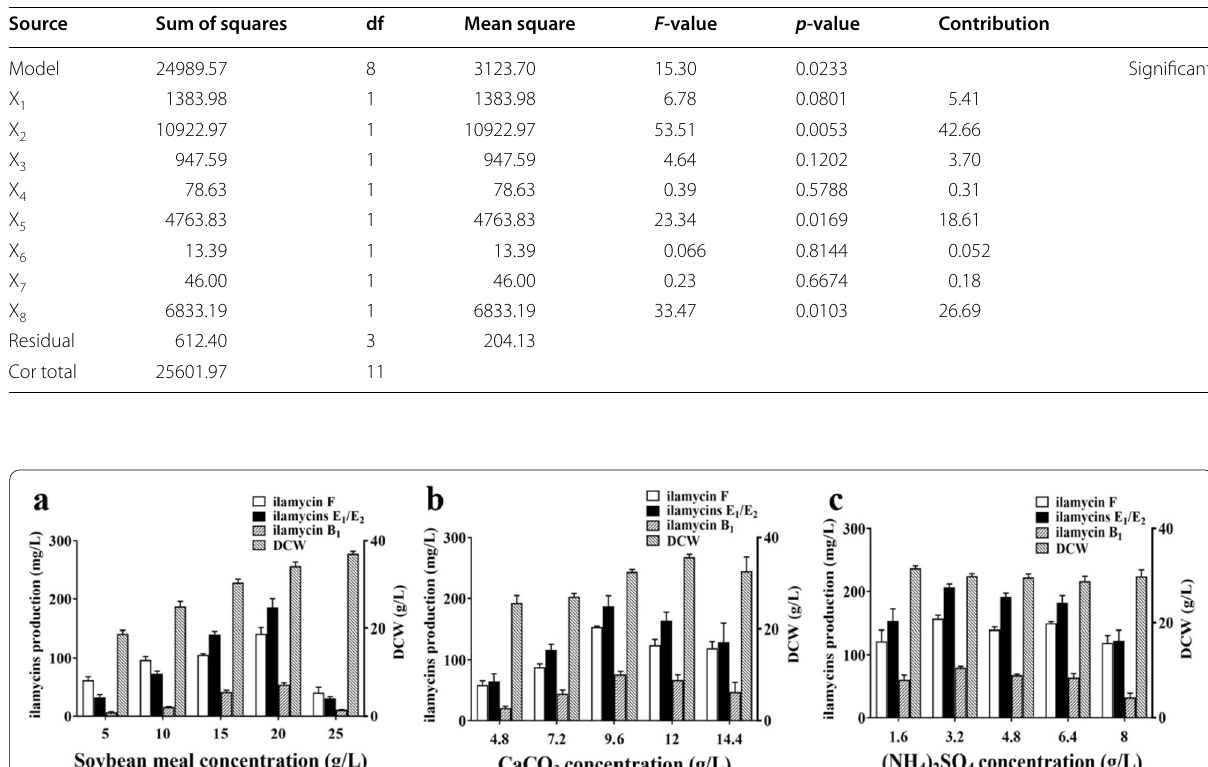
Table 1 Results of PBD ANOVA analysis